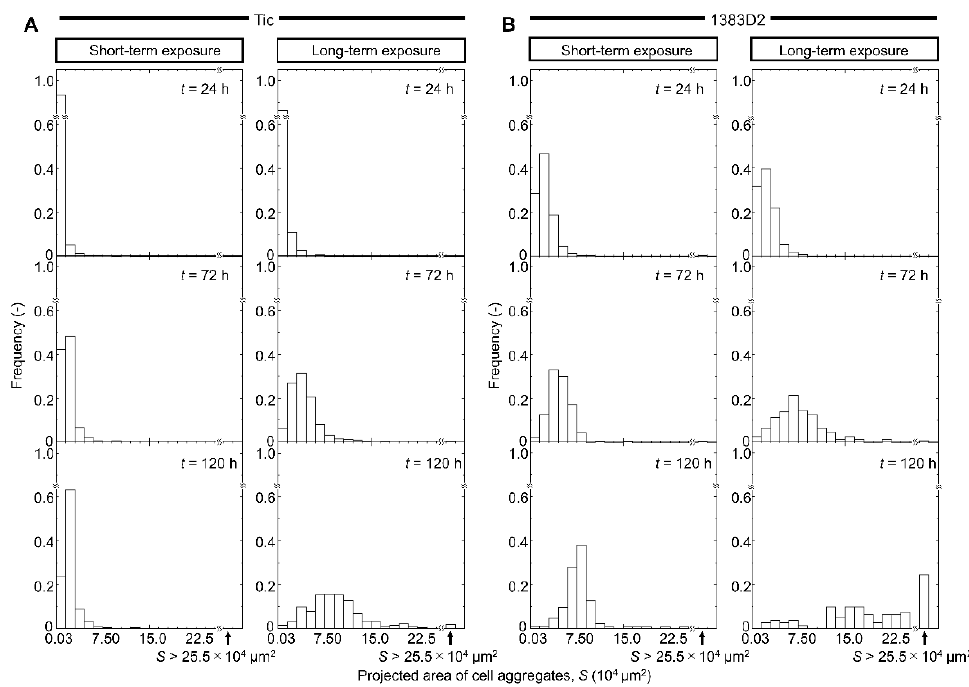
Figure 2. Distribution of projected area of two different hiPSC lines (( A ), Tic; ( B ), 1383D2) in suspension culture with short- and long-term exposure to ROCK inhibitor at 24, 72, and 120 h. Cell aggregates with 0–300 μ m 2 were not considered as aggregates. All distributions followed non-normal nature based on the Shapiro-Wilk test ( p < 0.05).